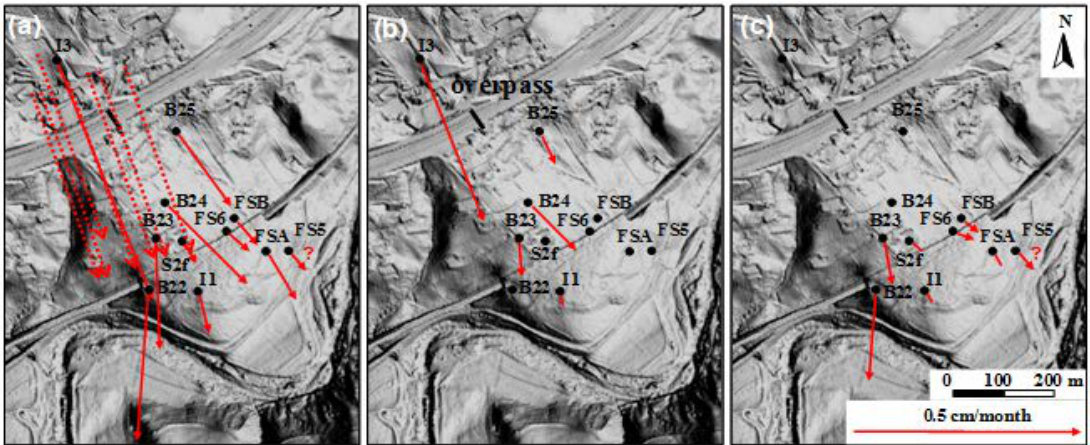
Figure 3. Displacement rate field relative to; ( a ) ground displacements obtained from inclinometer measurements (continuous lines) and theodolite measurements (dotted lines); ( b ) shear displacements along the shallower slip surface; ( c ) shear displacements along the deeper slip surface.